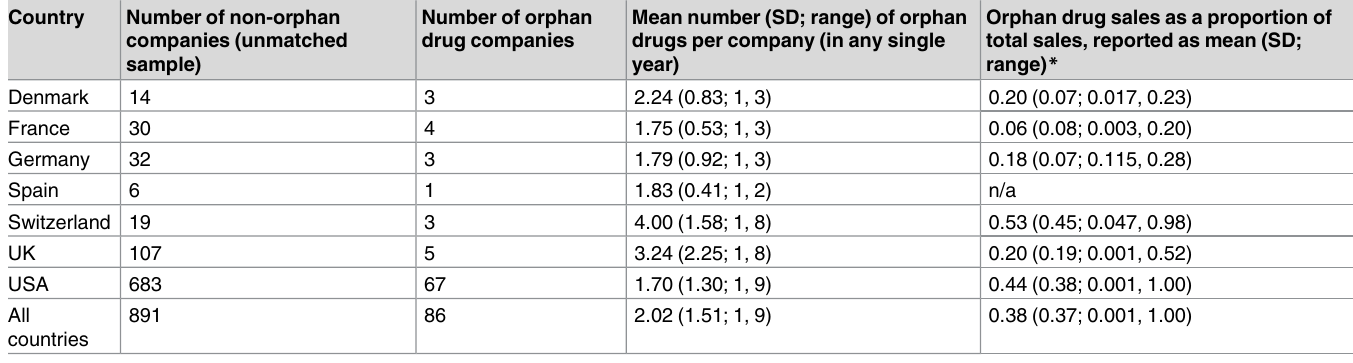
Table 2. Characteristics of the